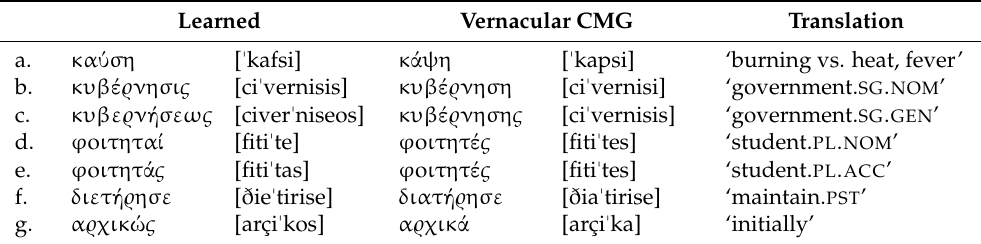
Table 1. Examples of learned form variation in the speech of Greek-Canadians. Learned Vernacular CMG Translation